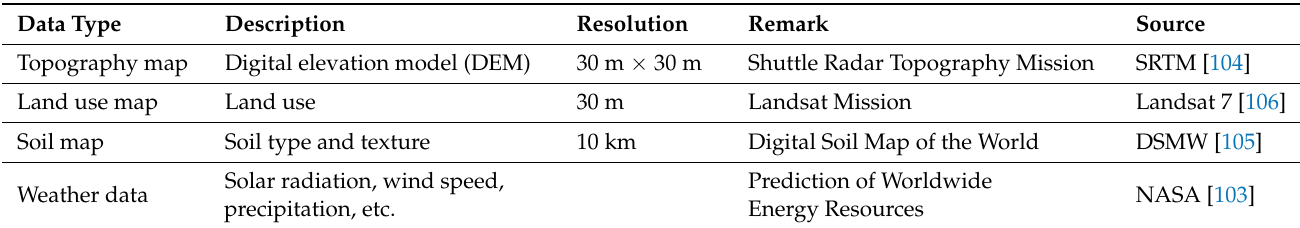
Table 4. Topographical and meteorological data of the study